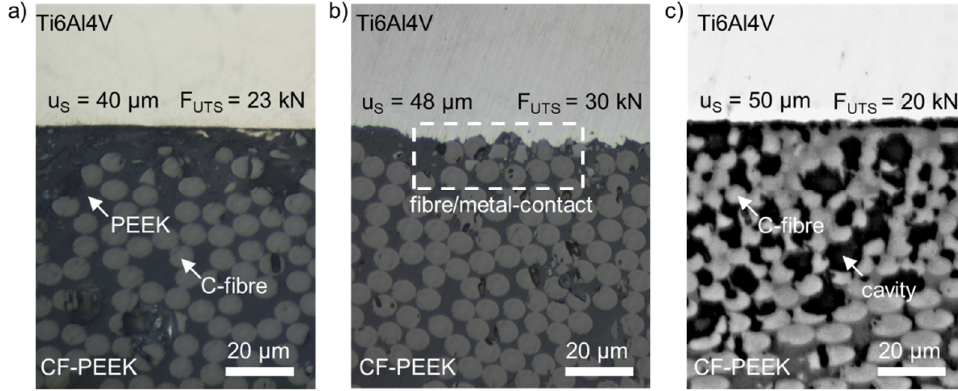
Figure 13. Microstructure of ultrasonically welded Ti6Al4V-fitting/CF-PEEK-tube joints depending on the displacement amplitude u S : ( a ) 40 µ m, ( b ) 48 µ m, and ( c ) 50 µ m with F USW : 150 N and v S : 28°/s (4.5 mm/s) with the resulting ultimate tensile shear force F UTS.